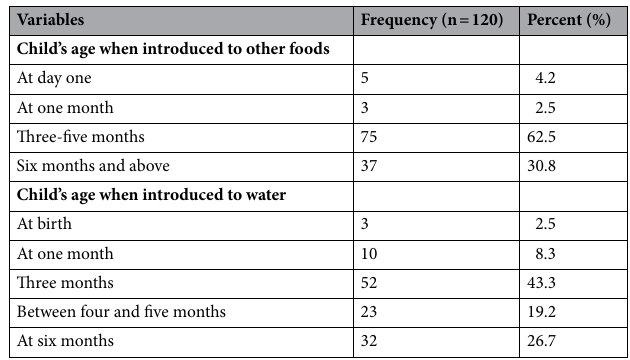
Table 2. Age at introduction of complementary